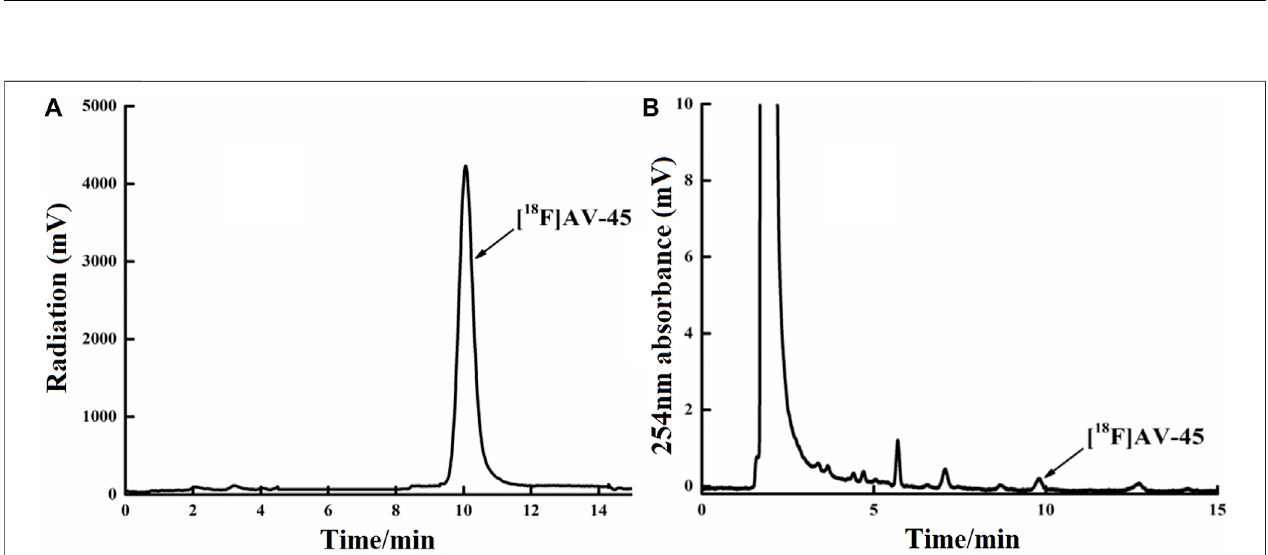
FIGURE 6 | Curve of the [ 18 F] AV-45 fi nal product in analytical HPLC (undiluted). (A) The samples curve obtained from the radioactivity detector, in which the only large peak is the [ 18 F] AV-45 peak; the time to peak of [ 18 F] AV-45 is approximately 9.8 min, similar to the AV-45 standard. (B) The samples curve obtained by the ultraviolet detector, in which the fi rst, larger peak is the ethanol peak, and the [ 18 F] AV-45 peak, indicated by the arrow, is very small; this corresponds to the radioactive peak.